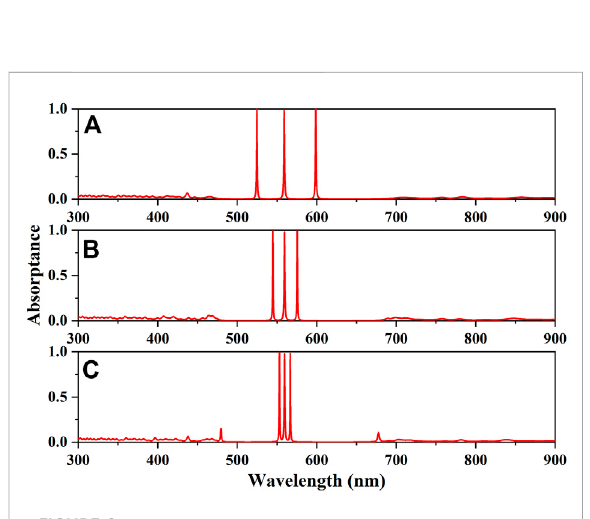
FIGURE 8 Absorption spectra of the PC (AB) 5 D(BA) N D(AB) N D(BA) 20 with d D = 130.3 nm and k D = 0.0023. (A) N = 2. (B) N = 4. (C) N = 6.